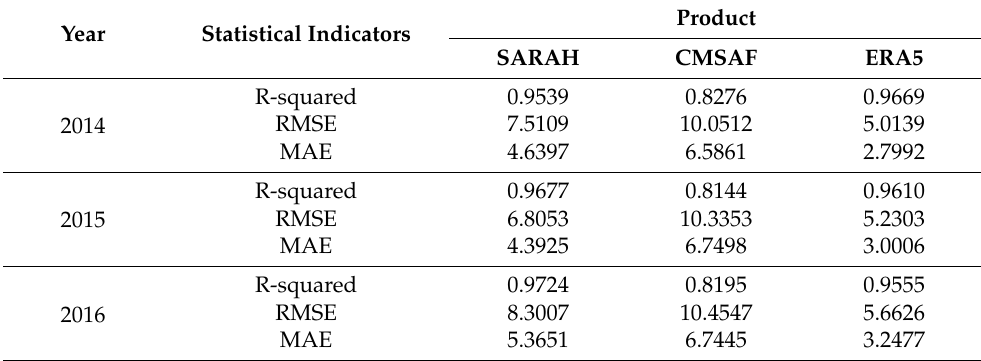
Table 4. Performance evaluation of the products (SARAH, CMSAF, and